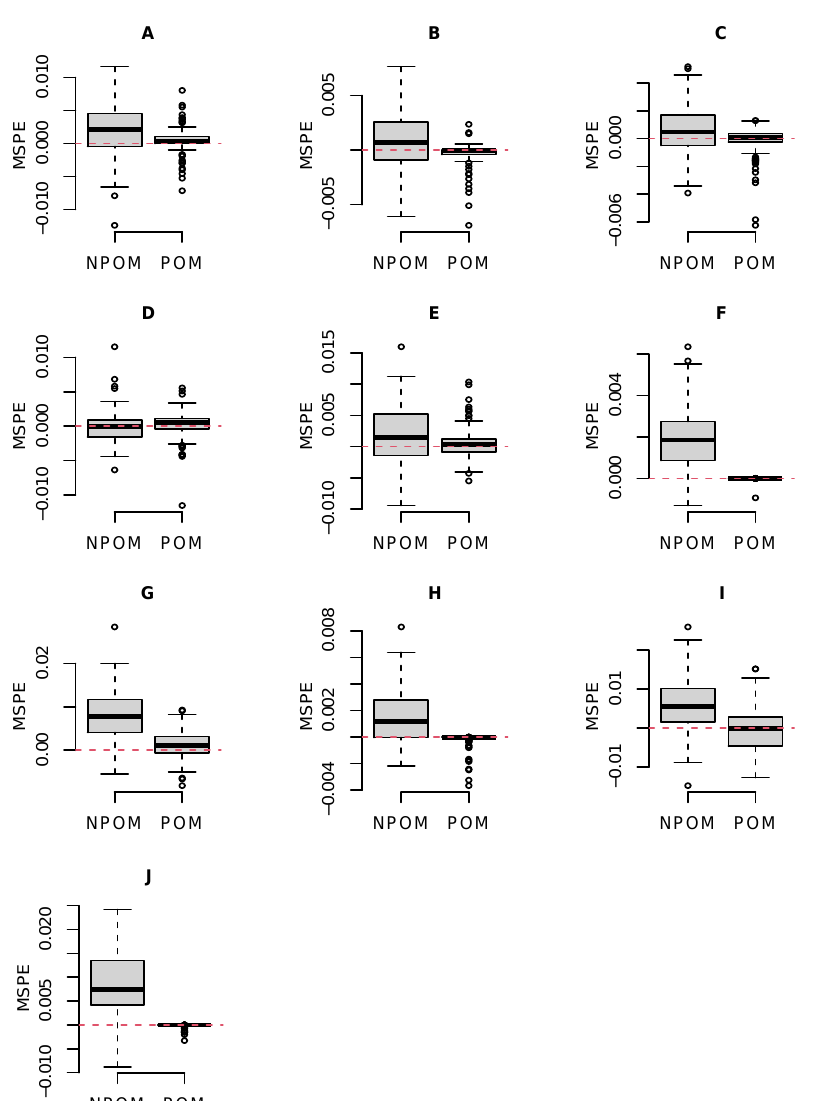
Figure 7. The result of the empirical application of SERP on the sensory data, showing the pairwise differences of the out-of-sample MSPE of SERP from (N)POM, for all panelists ( A – J ). The horizontal dashed lines indicate the mark of SERP improvement over NPOM and